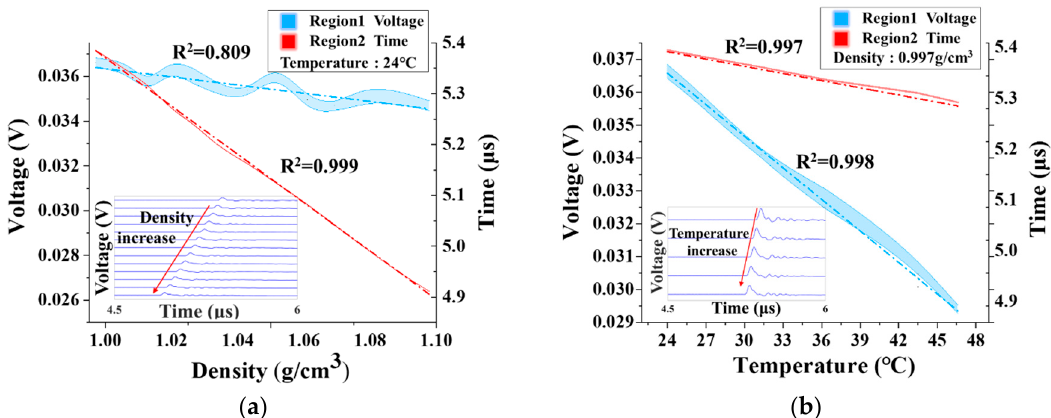
Figure 3. Measured PA signal in response to ( a ) ρ at 24 ◦ C and ( b ) T at 0.997 g / cm 3 . Inset: Dependence of wave velocity on ( a ) ρ and ( b ) T